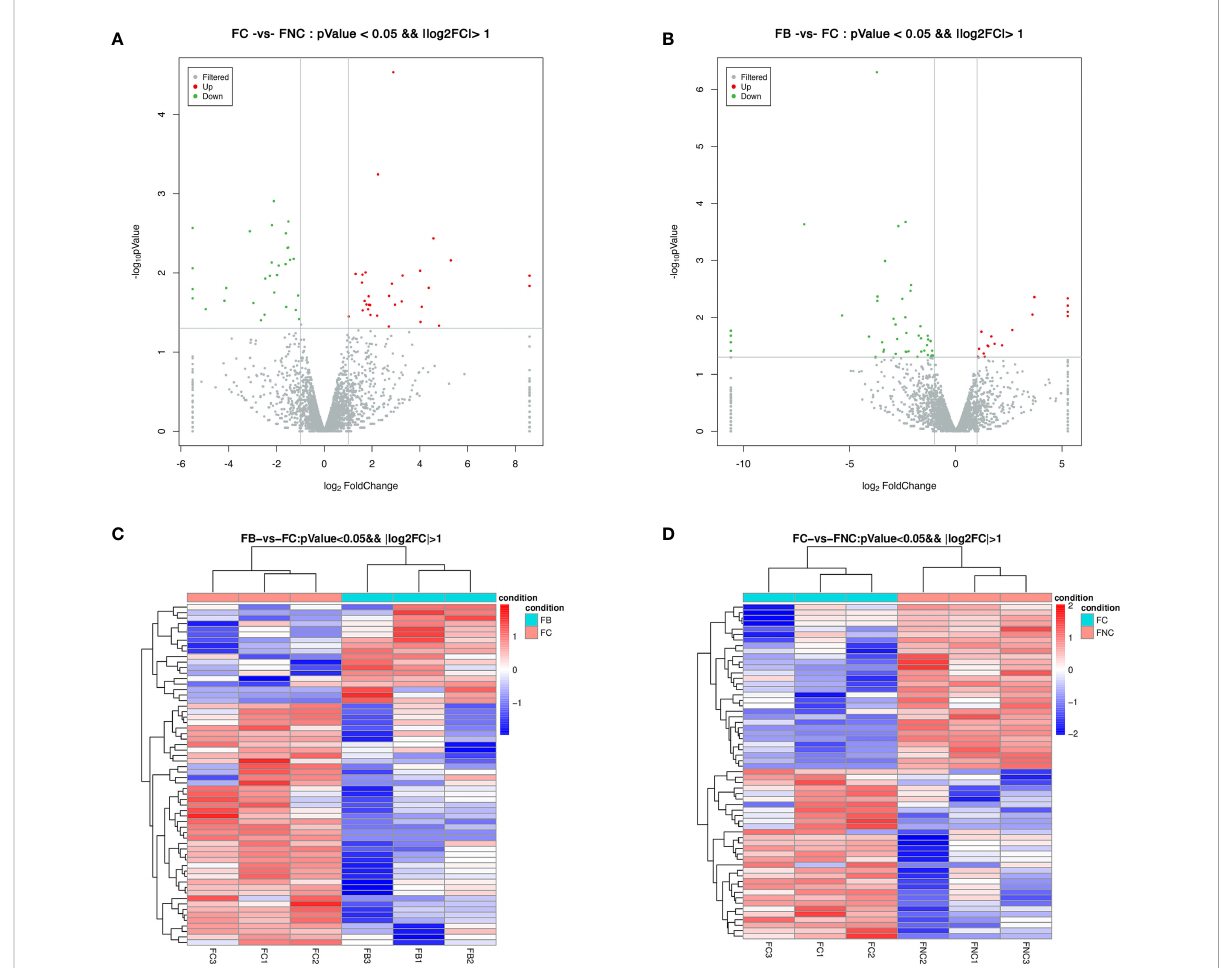
FIGURE 4 Differentially expressed lncRNAs (DELs) in pomegranate. Volcano plot of DELs in FC vs FNC (A) and FB vs FC (B) . Red and green dots represent signi fi cantly up-regulated and signi fi cantly down-regulated genes, respectively. Heat map of DELs based on hierarchical clustering analysis in FC vs FNC (C) and FB vs FC (D) . Red and blue indicate the highest and lowest expression level of